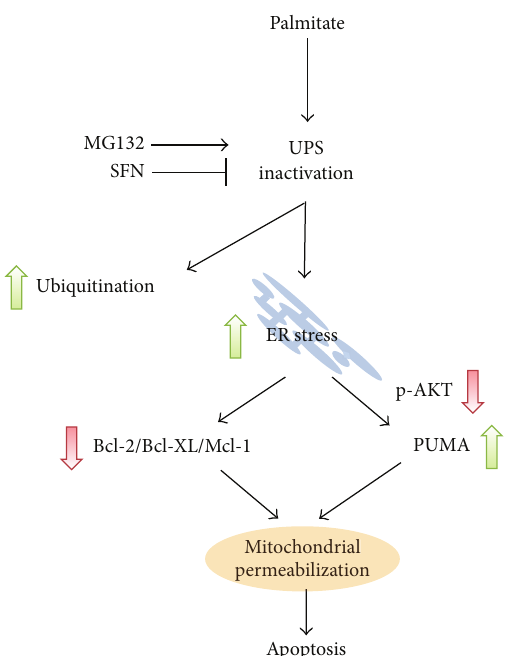
Figure 8: Proposed model for the role of UPS inactivation in palmitate-induced 𝛽 -cell apoptosis. Palmitate induces inactivation of the UPS in 𝛽 -cells resulting in increased ubiquitinated proteins, ER stress, and posttranscriptional inactivation of Bcl-2 and other prosurvival Bcl-2 proteins. In addition, AKT is dephosphorylated leading to upregulated expression of the BH3-only protein PUMA. These signals converge on mitochondrial permeabilization causing 𝛽 -cell